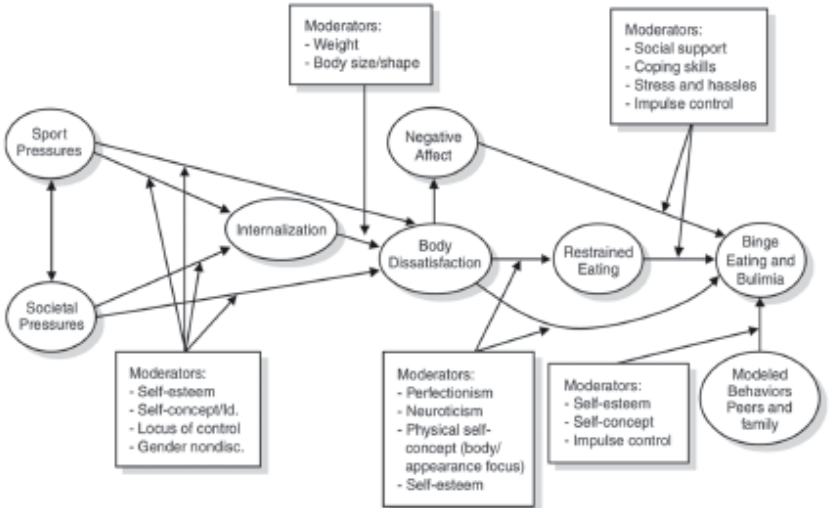
Figure 3. Etiological model showing the interplay of eight risk or causal risk constructs (shown in circles) considered as factors in the development of disordered eating in athletes (Petrie & Greenleaf, 2012). Used with permission from license # 5232220735165, granted on 18 January 2022. Cited within